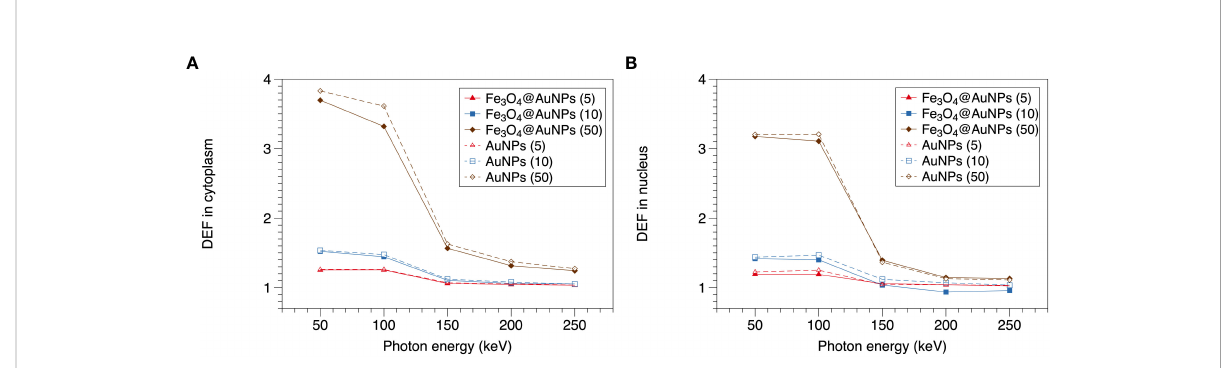
FIGURE 7 Function of DEF and photon energy in (A) cytoplasm and (B)